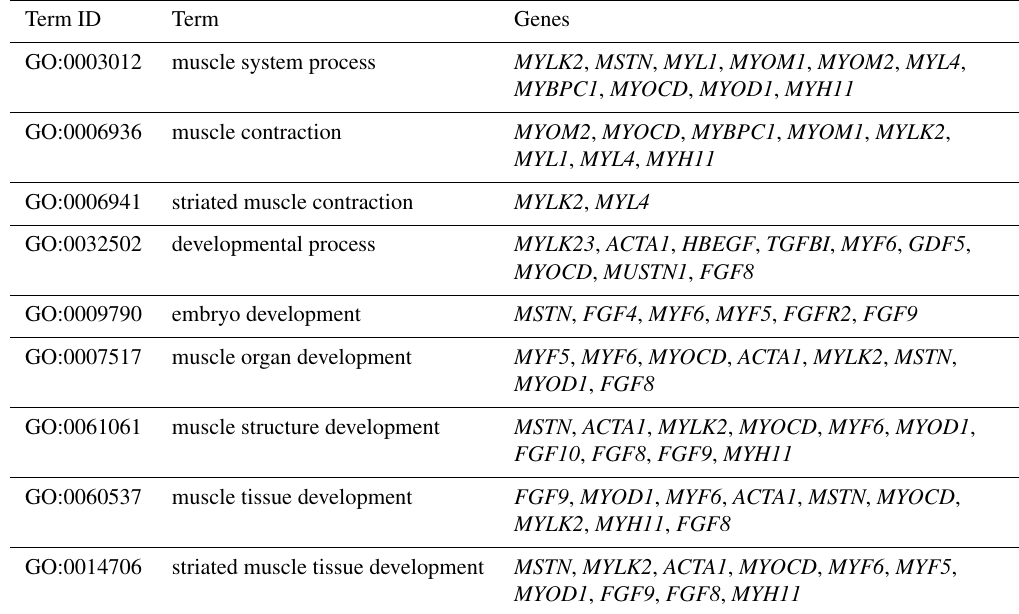
Table 2. Significantly enriched biological process terms involved in muscle growth and development.